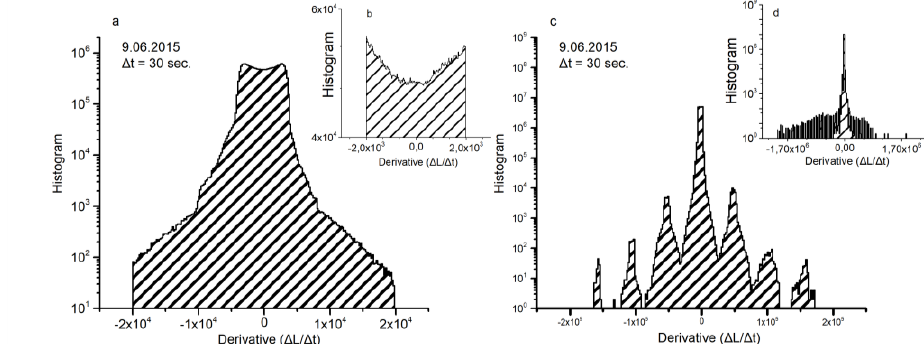
Fig. 1. The distribution of the values of the time derivative of the phase signal on different ranges.